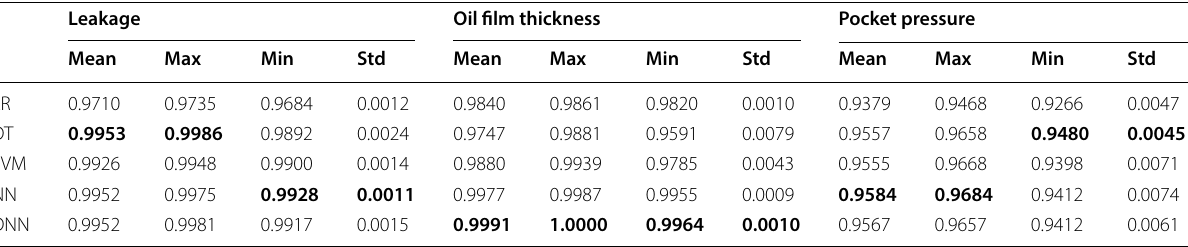
Bold values indicate the best score of the columns